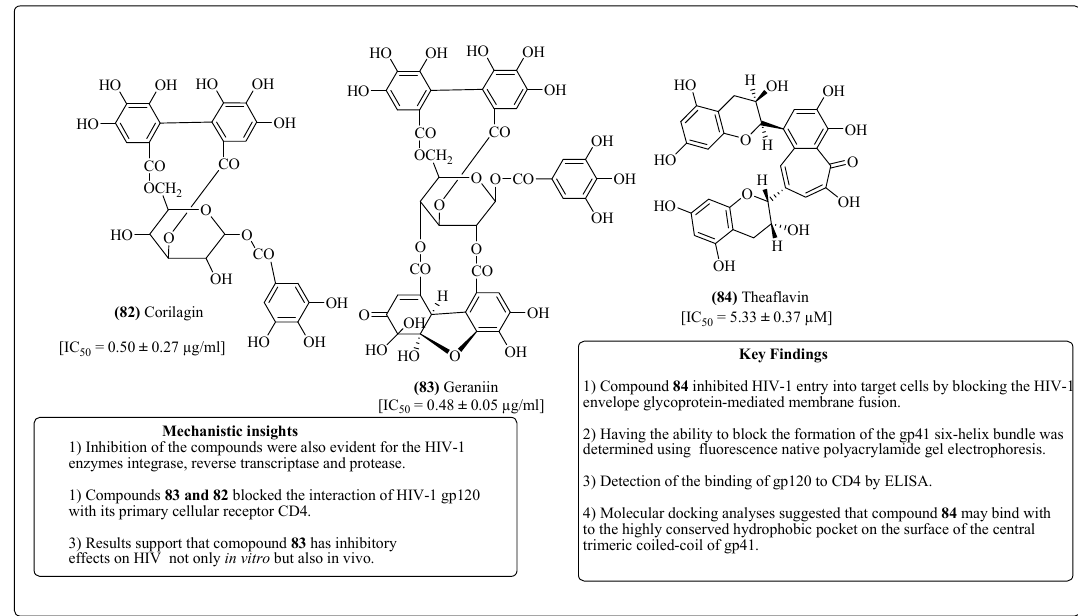
Figure 16. Tannins with anti-HIV properties.